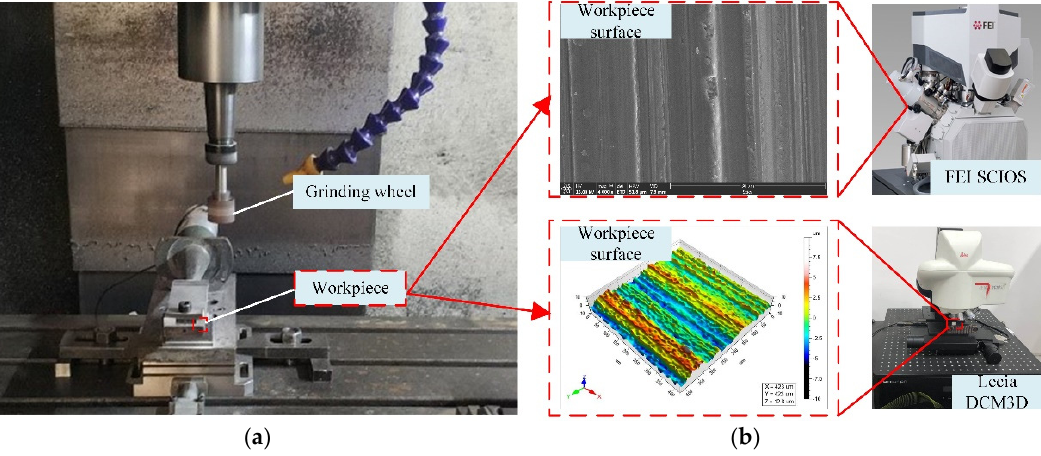
Figure 7. Experimental procedure. ( a ) Experimental platform. ( b ) Surface measurement of Nano-ZrO 2 . Table 1. Single-factor grinding experimental machining parameters. Exp. Number